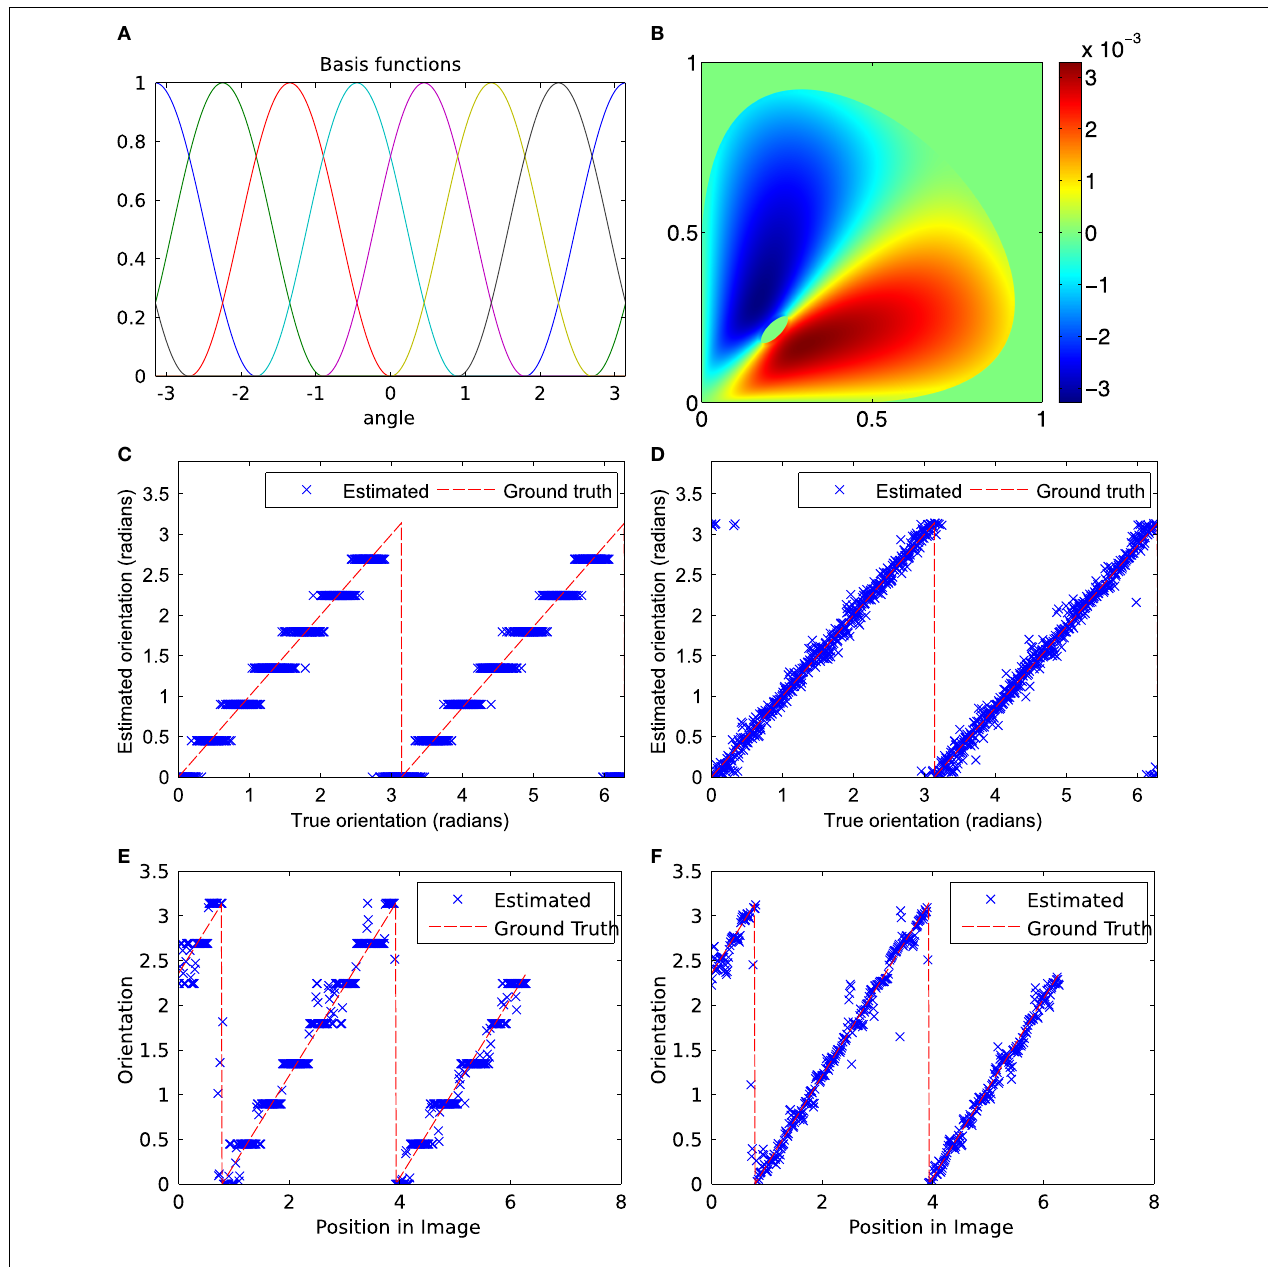
FIGURE 13 | Evaluation results: Stimuli from Figures 9 and 10, seven channels, repeated until convergence . (A) Basis functions used in all experiments with seven channels. (B) Plot of look-up table for the function